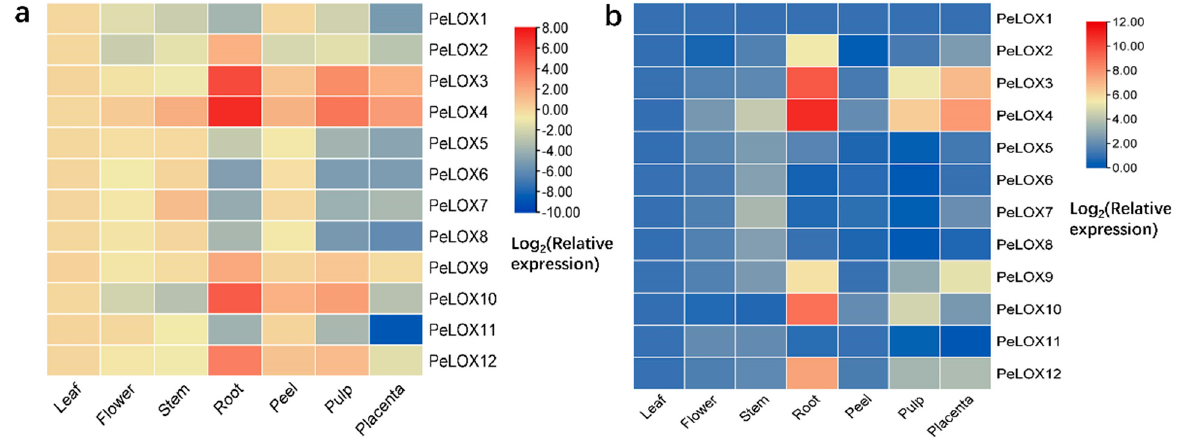
Figure 7. Expression profiles of PeLOX genes in various tissues of passion fruit. The expression of different PeLOX genes were normalized against the expression of leaf ( a ) and PeLOX1 ( b ) in particular tissue. Blue indicates a low expression level and red indicates a high expression level.